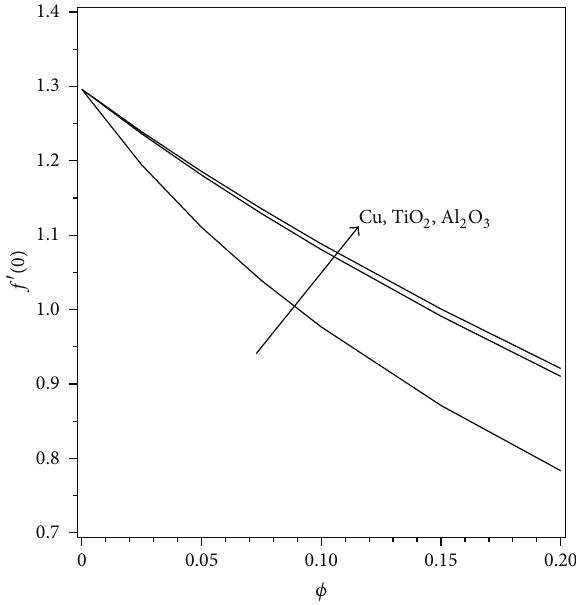
Figure 3: Variation of surface velocity 𝑓 󸀠 (0) with 𝜙 for different types of nanoparticles when Pr = 6.2 and 𝑚 = 0